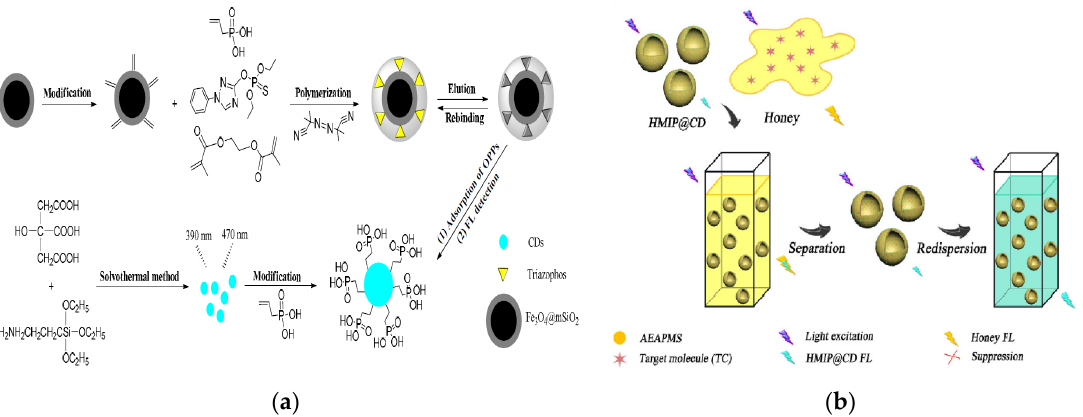
Figure 6. ( a ) Schematic of the preparation of core-shell magnetic molecularly-imprinted microspheres (MMIPs) of vinyl phosphate (VPA)-functionalized CQDs (MMIPs-CQDs@VPA) and the detection process for triazophos. Reproduced with permission from [112]. Copyright Polymers, 2019; ( b ) Schematic of fluorescent detection process of tetracycline (TC) in honey. Reproduced with permission from [115]. Copyright Talanta, 2018.